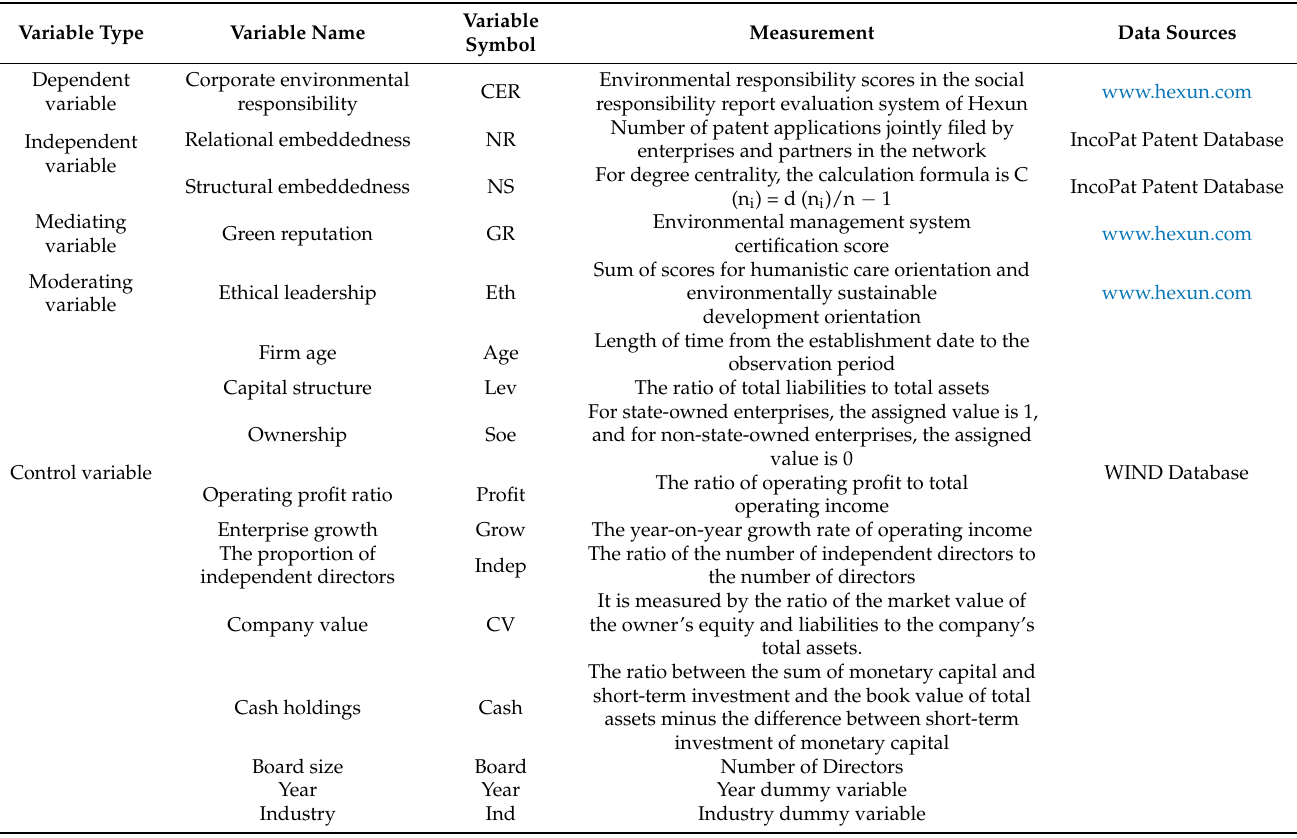
Table 1. Variable definition and